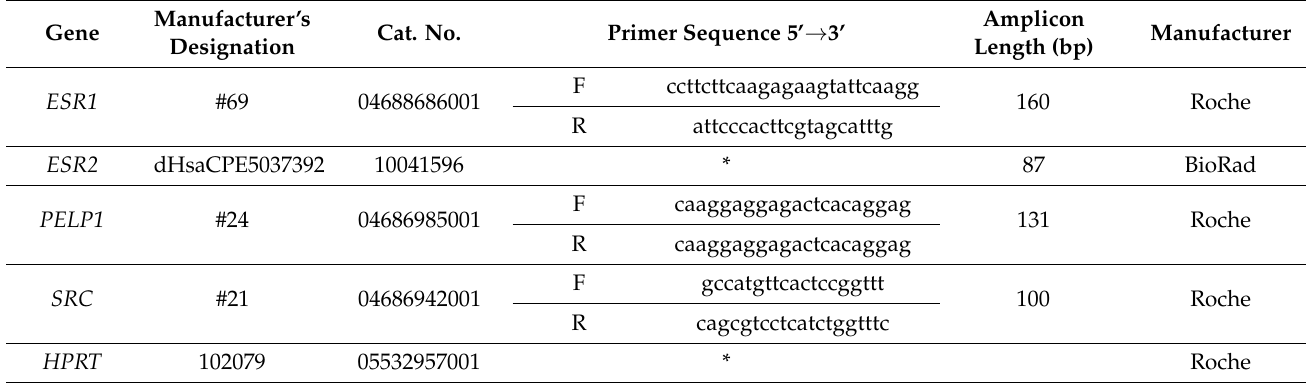
Table 2. Quantitative polymerase chain reaction probes and primer designations.